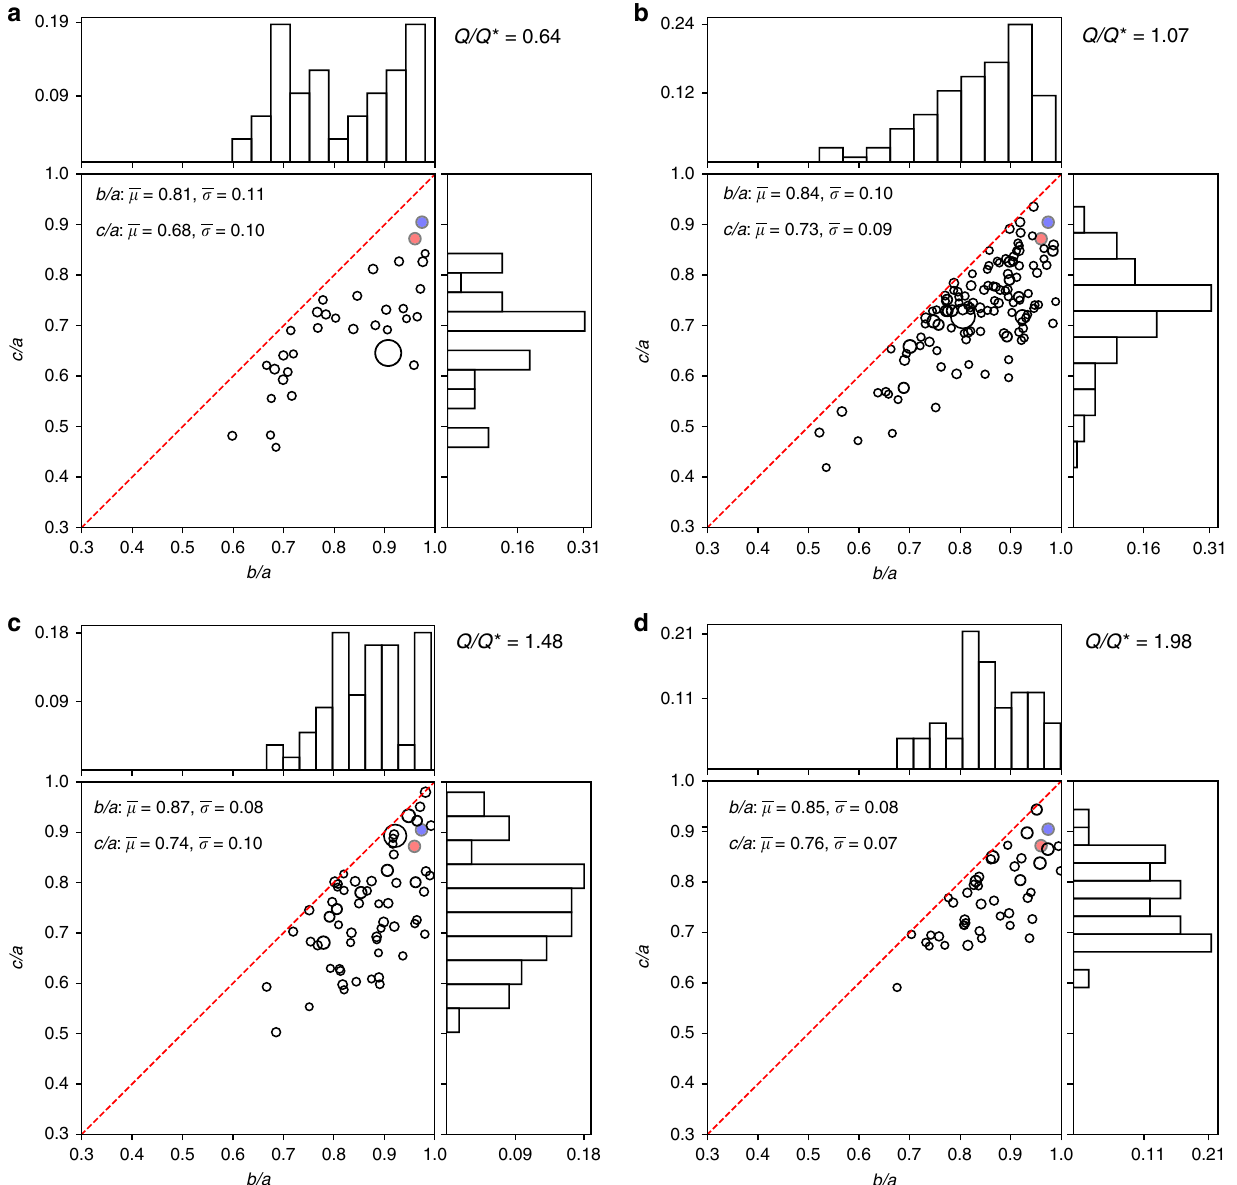
Fig. 1 Reaccumulated aggregates can have a wide range of shapes. For four different conditions that range in impact energy (represented by the impact energy relative to the calculated catastrophic disruption threshold, Q / Q* ), we show the axial ratios of the reaccumulated remnants, represented by a single point in each plot. From a to d , the impact energy Q is increased from below Q* ( a ) to above Q* ( b – d ). The marginal distributions of the minor-to-major axis ratios ( c / a ) and the intermediate-to-major axis ratios ( b / a ) are also presented. The relative radius of each aggregate is represented by the radius of its data point. The axial ratios of Ryugu and Bennu are shown as blue and red points, respectively (Note: the sizes of these points do not re fl ect the relative size of Ryugu and Bennu to the aggregates formed in these simulations. The maximum resolution attained in our simulations results in aggregates that are larger by a factor of 4 – 8 than Ryugu and Bennu). The mean, (cid:1) μ , and standard deviation, (cid:1) σ , of the axis ratios of all reaccumulated aggregates in each run are shown in the legends of the panels. For these impact conditions, we fi nd that the higher the impact energy, the more spherical the average